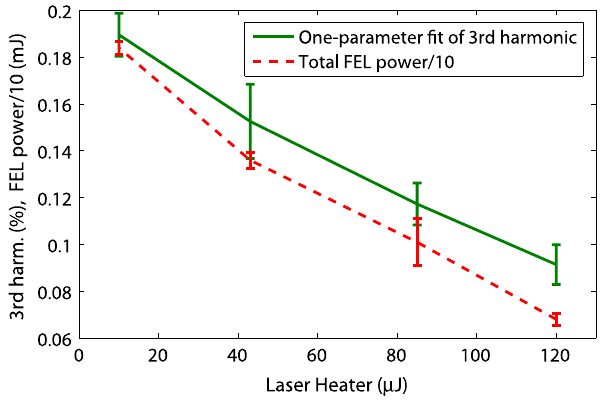
FIG. 10. Percentage of harmonic power vs laser heater setting. As the FEL performance drops (dotted red line), the percentage of third harmonic also drops (solid green), indicating enhanced sensitivity to electron beam quality at higher